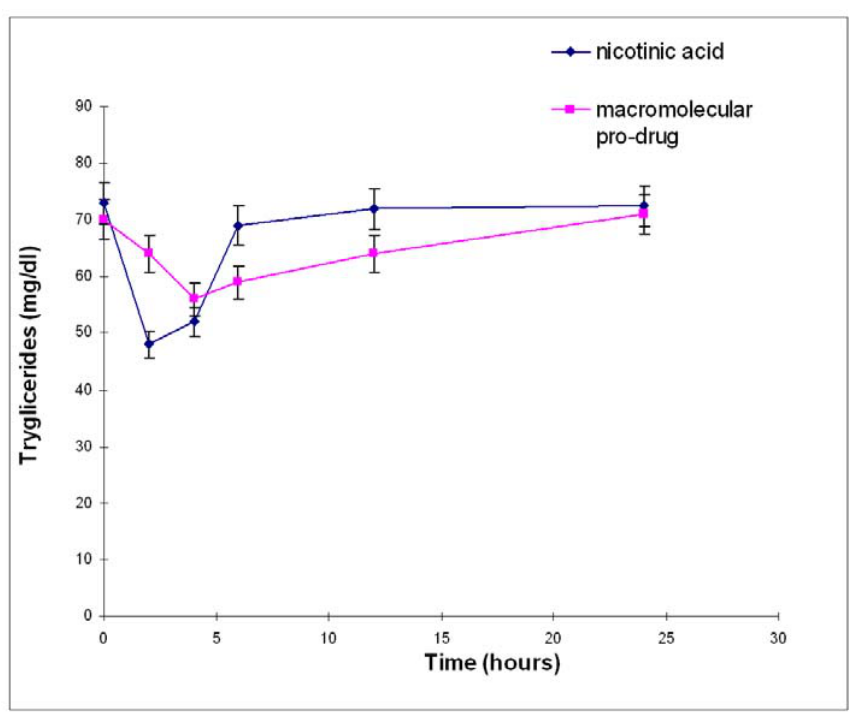
Fig. 3 The plasma level of triglyceride (mg/dl) after administration of free nicotinic acid (– (cid:2) –) and macromolecular pro-drug (– (cid:3)